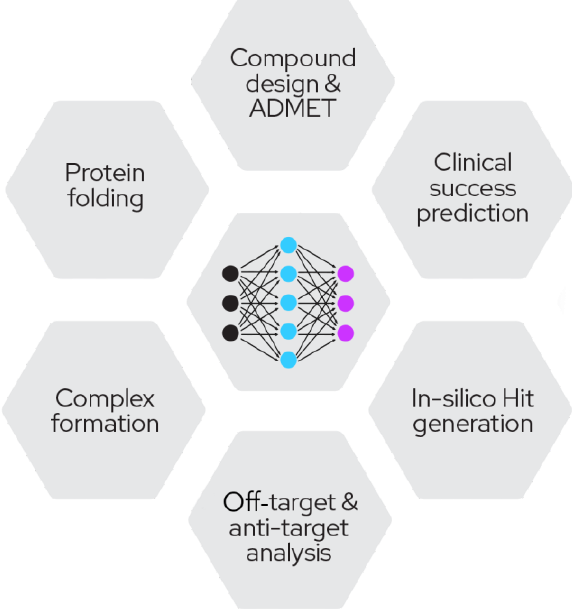
Figure 8. Fields of impact for novel machine-learning approaches.